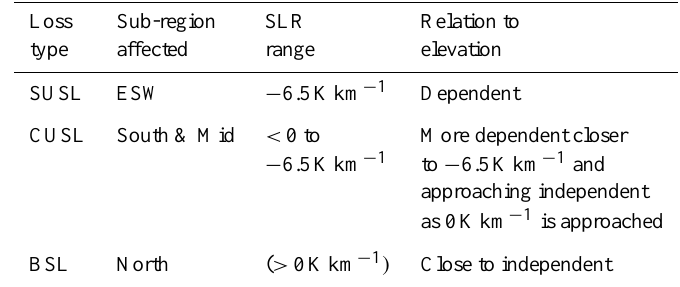
Fig. 10. Distribution of permafrost probabilities for each sub-region under the climate modelling scenarios. Permafrost probabilities are grouped into classes of 0.1. Table 2. Permafrost loss pattern summary by